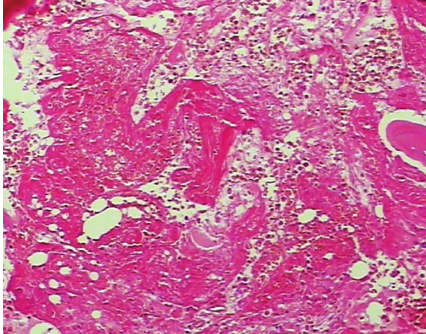
Figure 4: Necrosis in both soft tissue and bone, with haemorrhage in inflammatory pesudotumor. HE ×